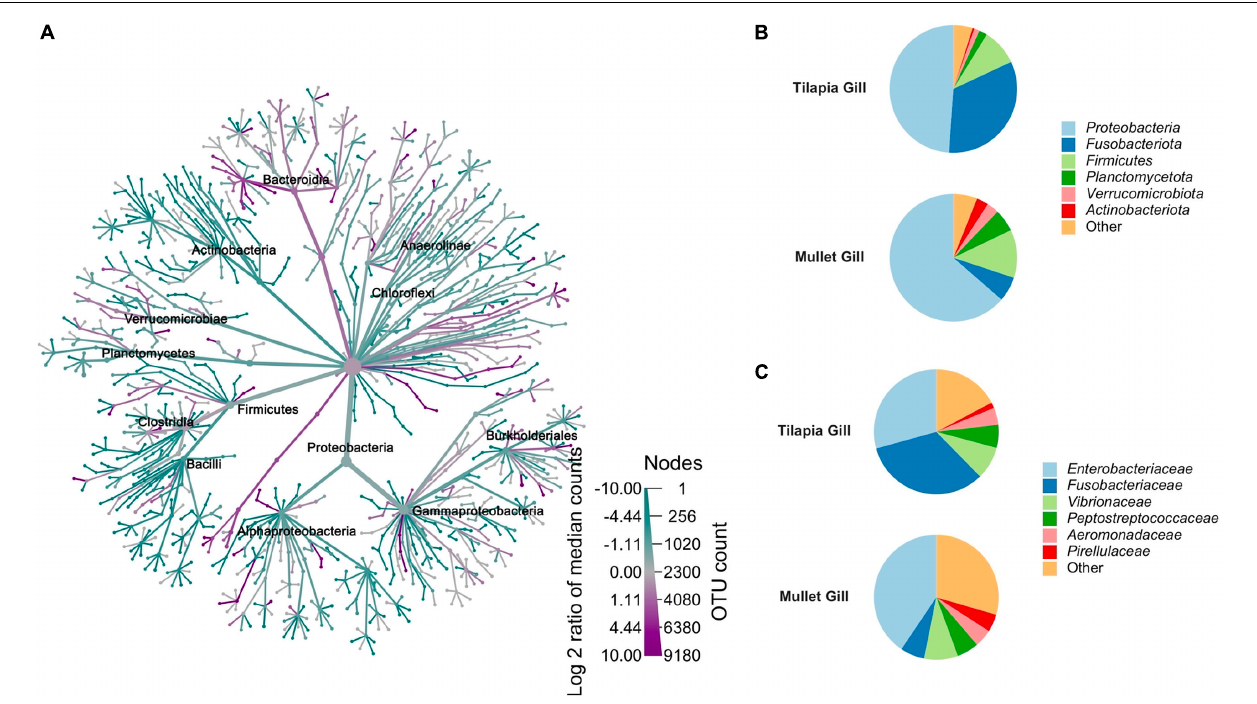
FIGURE 4 | Comparison between co-cultured Nile tilapia and grey mullet gill microbiome composition ( n = 24 fish/species) across two farms. (A) Metacoder heat tree showing the difference in microbiome phylotypes between the tilapia and mullet gill microbial communities. Nodes in the heat tree correspond to phylotypes, as indicated by node labels, while edges link phylotypes in accordance with the taxonomic hierarchy. Node sizes correspond to the number of observed operational taxonomic units (OTUs). Colors represent the log fold difference of a given phylotype’s median relative abundance in tilapia compared with mullet. Only significant differences, Wilcox rank-sum test followed by a Benjamini–Hochberg [false discovery rate (FDR)] correction are colored. Taxa colored dark cyan represent enrichment in mullet and dark magenta in tilapia. (B) Pie chart represents mean relative abundance (%) of the most prevalent phyla in tilapia and mullet gill samples; all bacteria with an overall abundance > 3% were reported, and bacteria with an abundance of less than 3% were pooled and indicated as “Others”. (C) Pie chart represents mean relative abundance (%) of the most prevalent families in tilapia and mullet gill samples; all bacteria with an overall abundance > 3% were reported, and bacteria with an abundance of less than 3% were pooled and indicated as